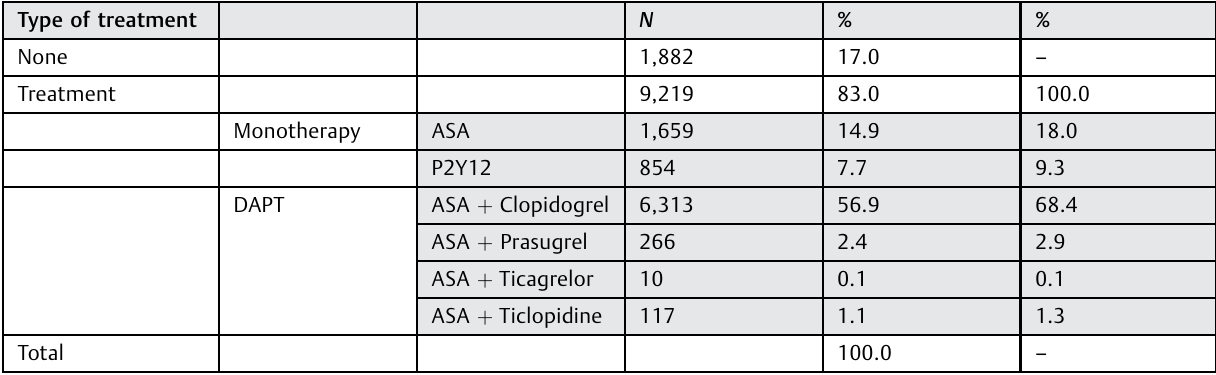
Table 2 Type of antiplatelet treatment Type of